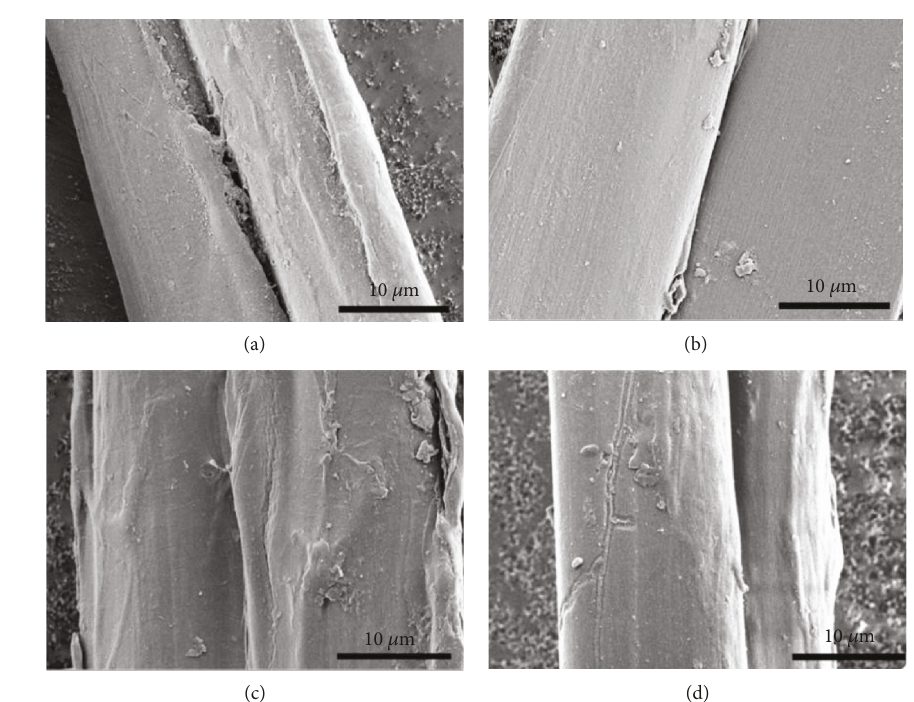
Figure 3: TG and DTG of the (a) original NCS and (b) cross-linked NCS.